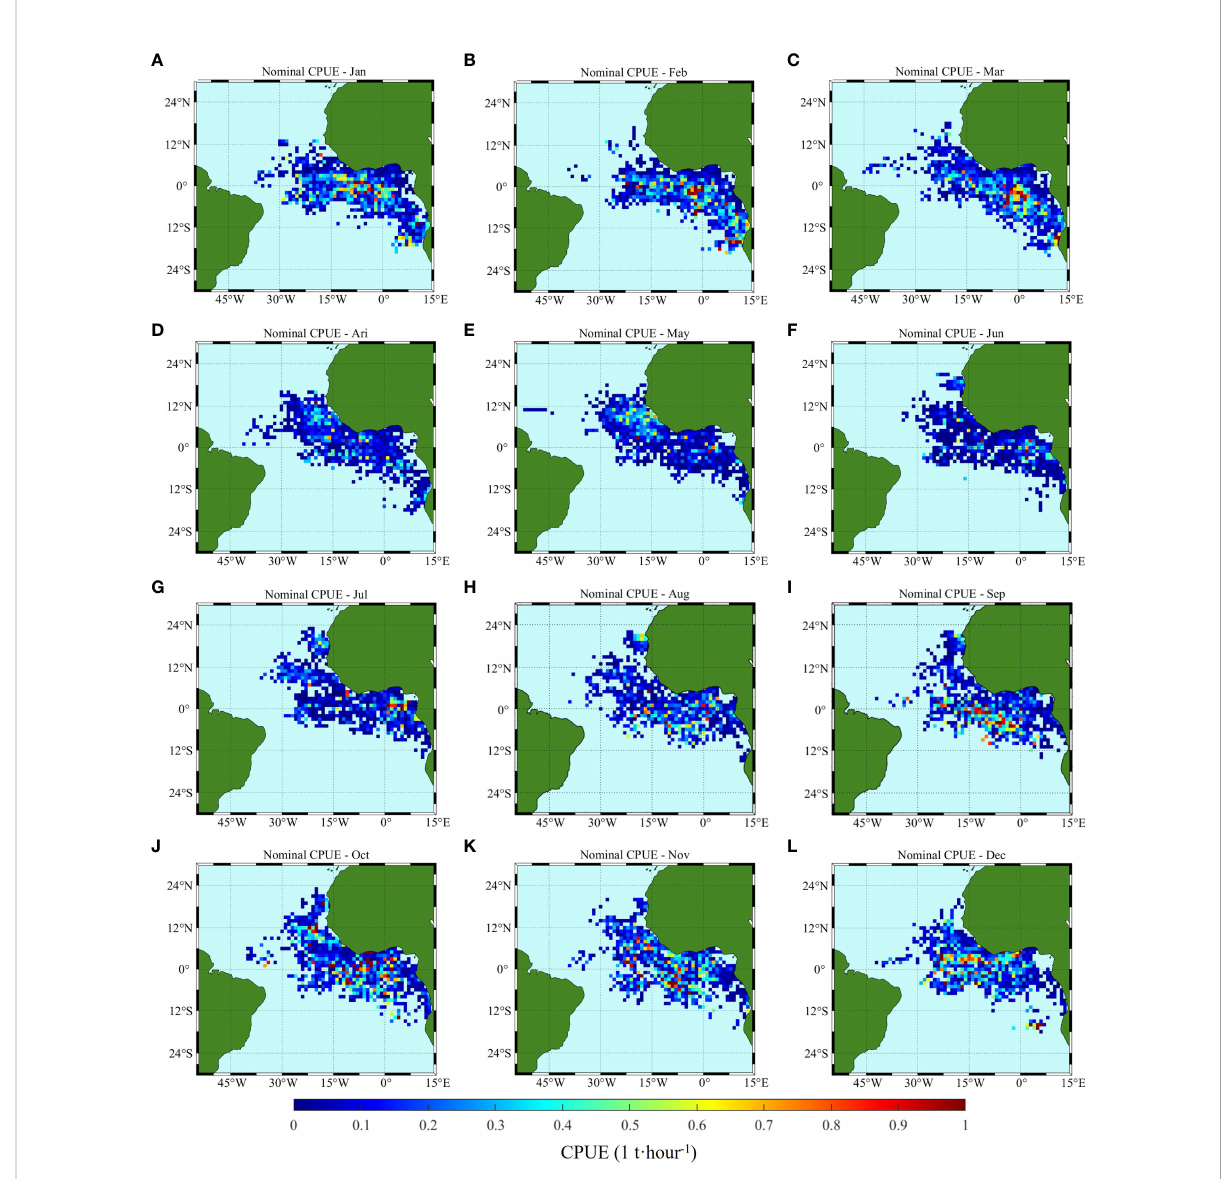
FIGURE 7 Climatology monthly spatial distribution of the original measured CPUE; (A – L) correspond to January to December,